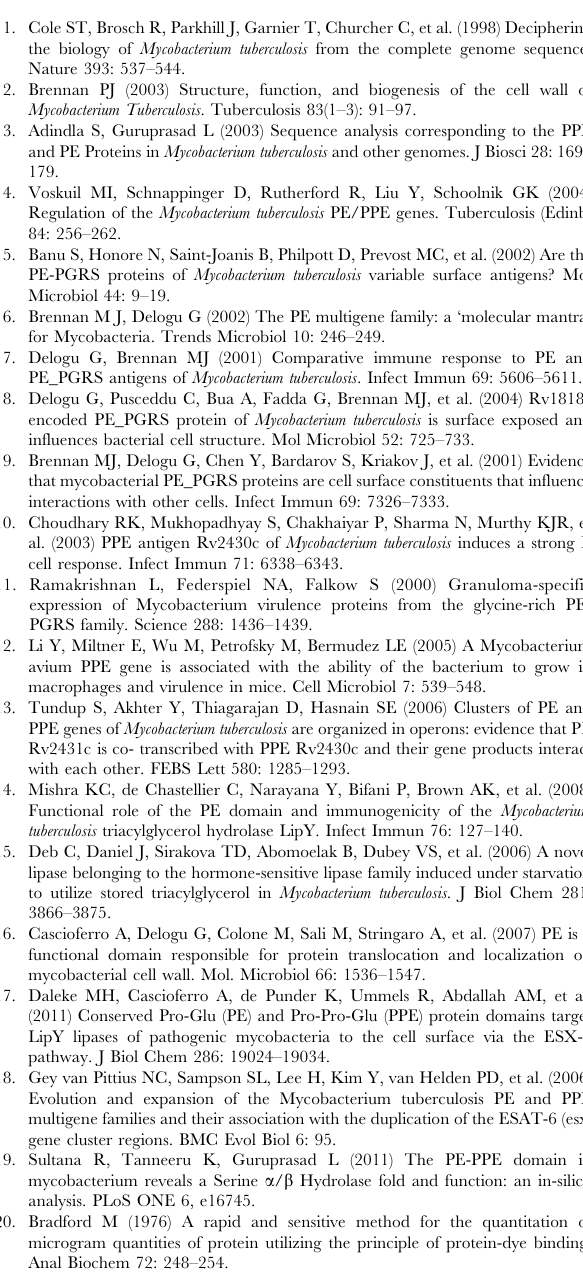
Figure S3 A time course of p -nitrophenylcaproate (pNPC6) hydrolysis at pH7.0, 37 u C with PE-PPE domain (black) and Ser199Ala mutated PE-PPE domain (red) of Rv1430 protein.